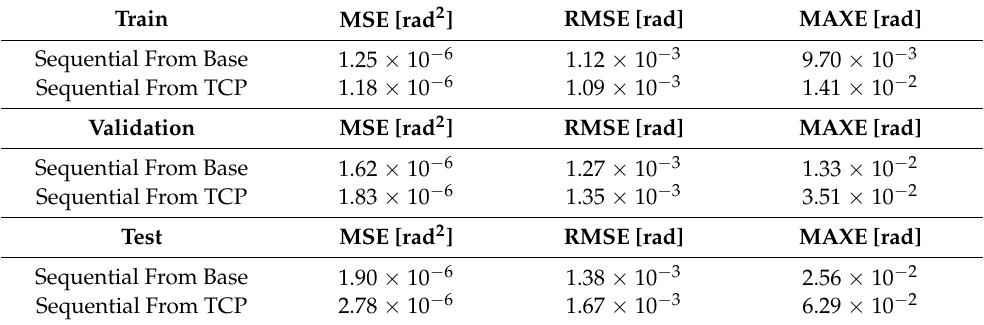
Table 10 states the training, testing, and validation errors in terms of the joint prediction for the different models (global approach and sequential method). The results show the capability of the ANN structure to model any path or data point within the workspace. Table 10. Sequential IK procedure error results for the training, validation, and testing phases. Train MSE [rad 2 ] RMSE [rad] MAXE [rad] Sequential From Base 1.25 × 10 − 6 1.12 × 10 − 3 9.70 × 10 − 3 Sequential From TCP 1.18 × 10 − 6 Validation MSE [rad 2 ] Sequential From